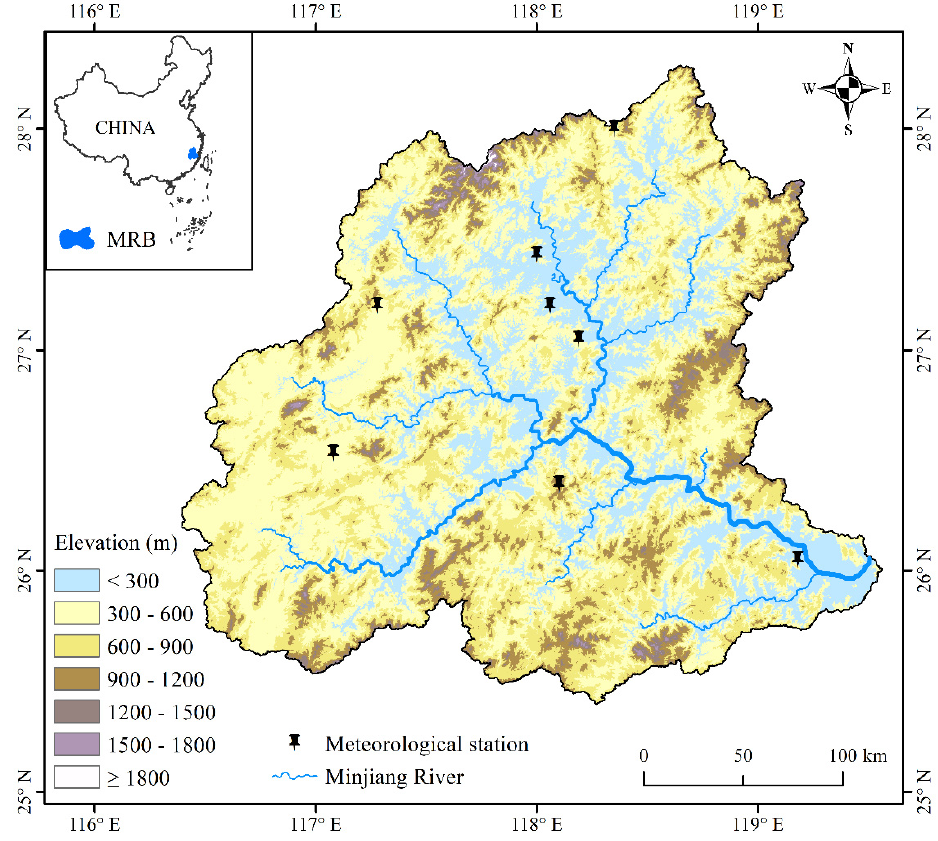
Figure 1. Topography and river network of the Minjiang River Basin (MRB).